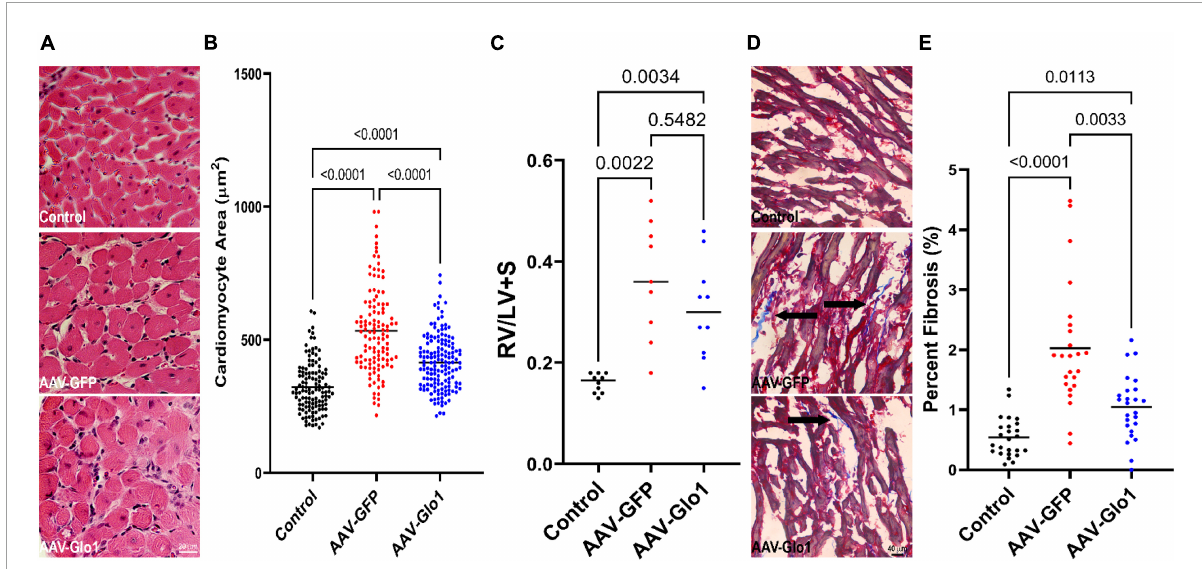
FIGURE5 AAV-Glo1 had a modest effect on RV hypertrophy but reduced RV fibrosis. (A) Representative images of hematoxylin and eosin-stained RV sections. Scale bar 20 µ m. (B) Quantification of RV cardiomyocyte cross-sectional area. Glo1 overexpression reduced RV cardiomyocyte area. (C) Quantification of RV to LV + septum mass. p -values determined by one-way ANOVA with Tukey’s multiple comparisons test (D) Representative images of Masson-Trichrome stained RV sections to delineate fibrosis (marked by arrows). Scale bar 40 µ m. (E) Quantification of RV fibrosis area. AAV-Glo1 treatment reduced RV fibrosis. p -values determined by Kruskal-Wallis test with Dunn’s multiple comparison test in (B,E)